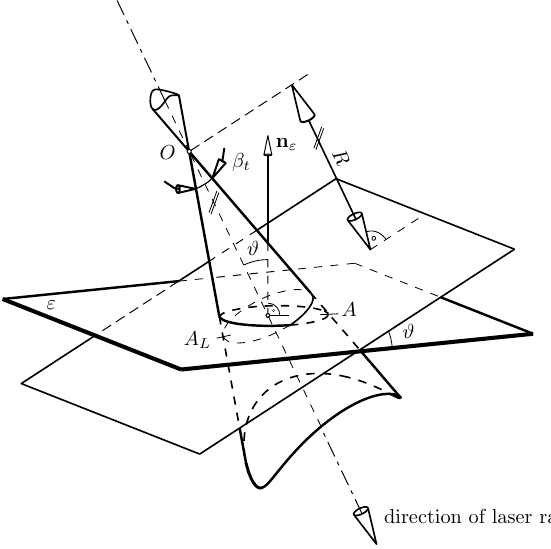
Figure 1: Geometric parameters of the radar equation. The angle ϑ formed by the laser ray and the normal of of the target plane ε is called incidence angle (Roncat et al., 2012). Its precise deter- mination is essential for calculating the diffuse BOA reflectance ρ d .